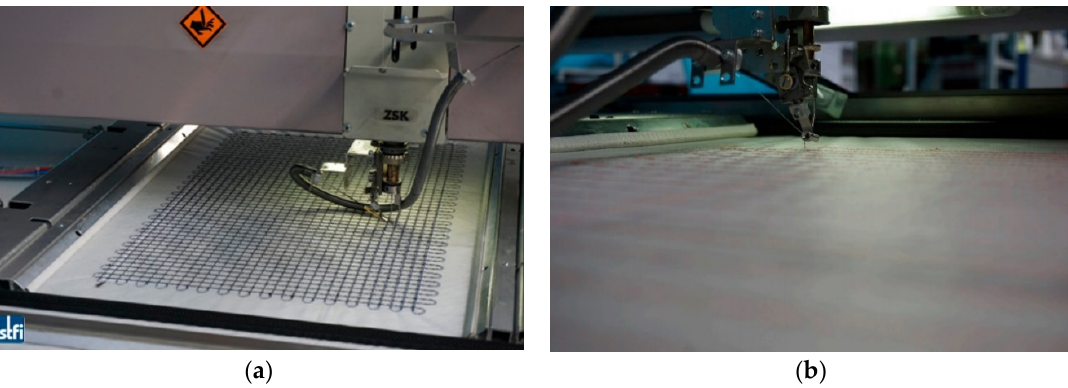
Figure 15. Modified embroidery machine ( a ) that was developed for simultaneous processing of the carbon fiber filaments and optical fibers on PVA nonwoven substrate ( b ) [51].